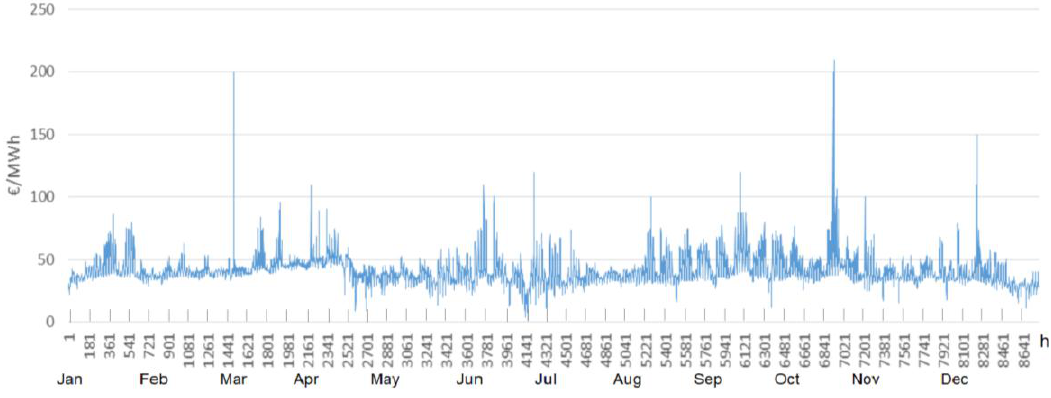
Figure 19. Electricity price distribution in Finland during 2013.